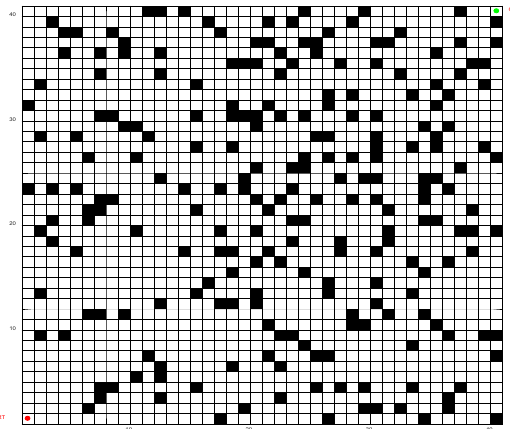
Fig. 1 . Path planning simulation